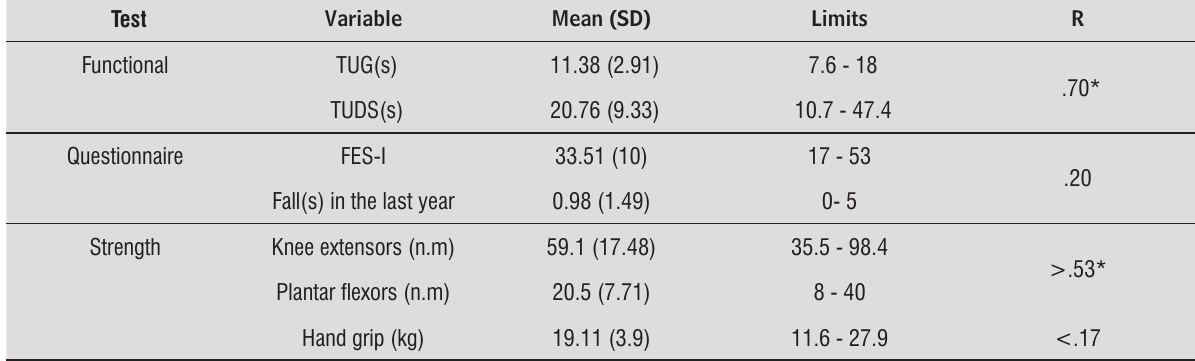
Table 2 - Studied variables of interest stratified by test (Pearson’s r)